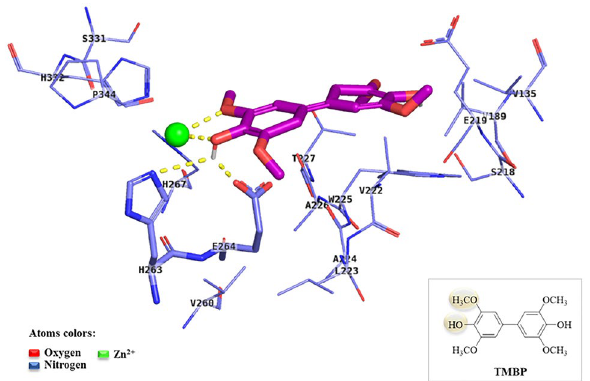
Figure 7. Interaction diagram of the consensual pose of TMBP (purple sticks and the inset for its chemical structure) at the active site of LaGp3. Blue sticks or lines represent interacting amino acid residues, and a green sphere represents the Zn 2+ ion. The dashed yellow lines represent hydrogen bonding interactions with the amino acids or zinc.